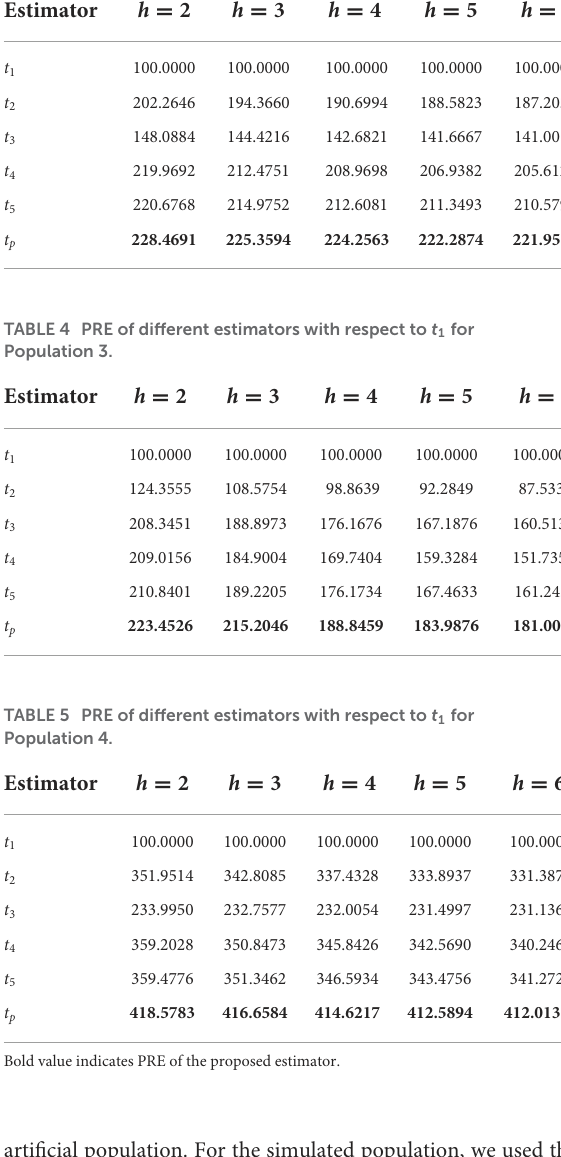
TABLE 3 PRE of different estimators with respect to t 1 for Population 2.